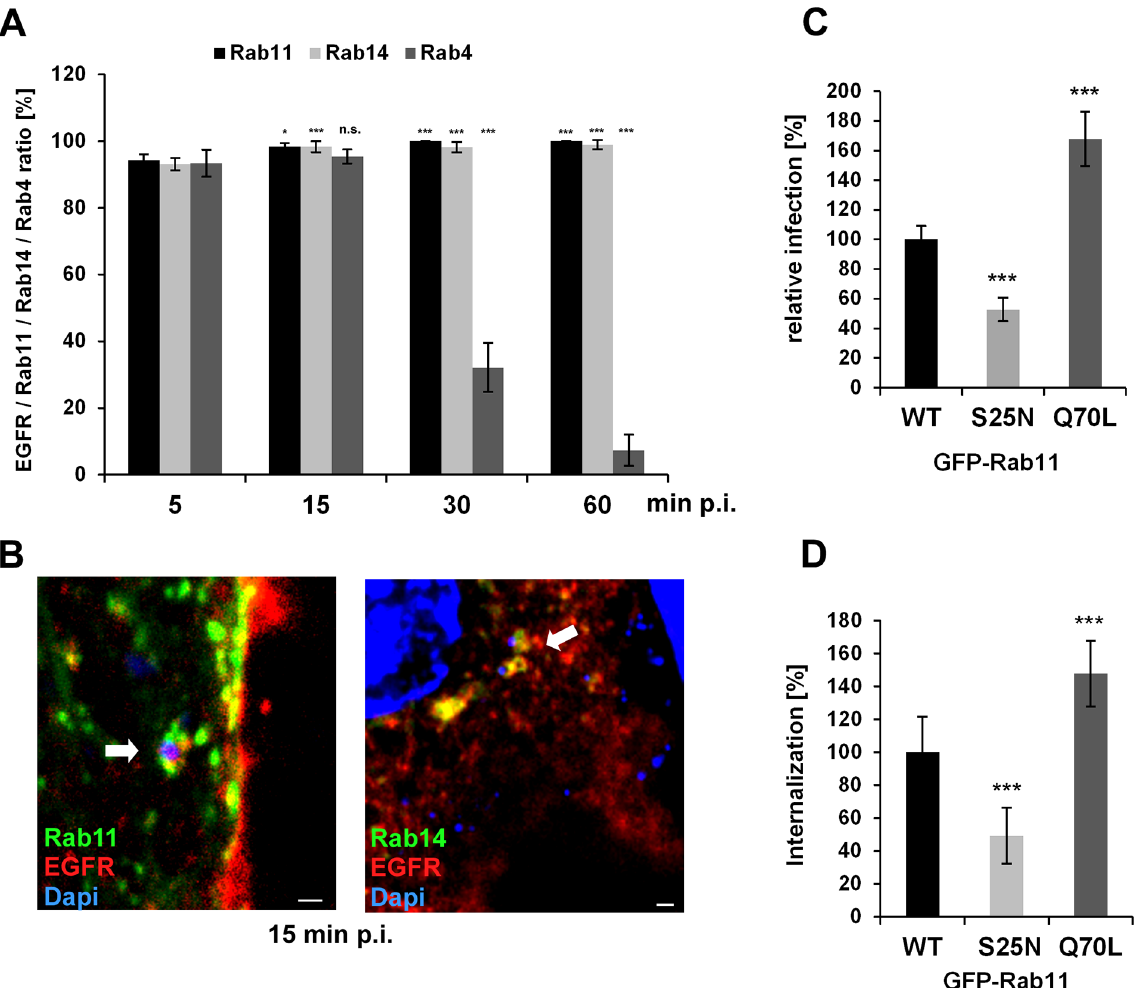
Fig 3. The early C . pneumoniae inclusion is a recycling endosome. (A) Quantificationof colocalization of EGFR-positive C . pneumoniae EBs with GFP-Rab11, GFP-Rab14, GFP-Rab4 at 5–60 min p.i. in transientlytransfected cells over the course of (n = 3). (B) Confocalimages of colocalization of EBs (visualizedwith DAPI) with GFP-Rab11 and EGFR (left), or with GFP-Rab14 and EGFR (right) at 15 min p.i. White arrows indicate colocalization. Bar 1 μ m. (C, D) HEp-2 cells stably expressingwild-typeGFP-Rab11 or the dominant-negative (S25N) or constitutivelyactive (Q70L) GFP-Rab11 variant. (C) Quantification of EB internalizationat 2 hpi in 30 individual cells (n = 4). (D) Quantificationof infection at 48 hpi in 40 visual fields (n = 4). P values: * (cid:20) 0.1; *** (cid:20) 0.001. n.s.–not significantly